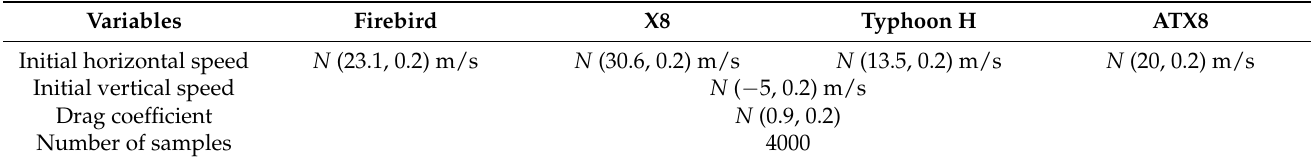
Table 5. Parameters for travelled horizontal distance